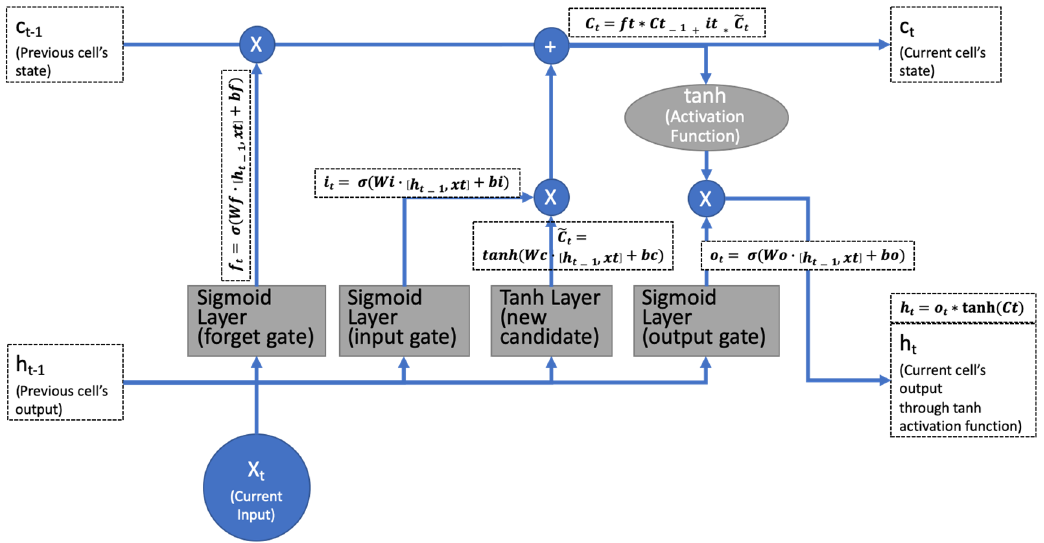
Figure 2. Standard long short-term memory (LSTM) using three gates (forget, input, and output) to eliminate the vanishing gradient problem.